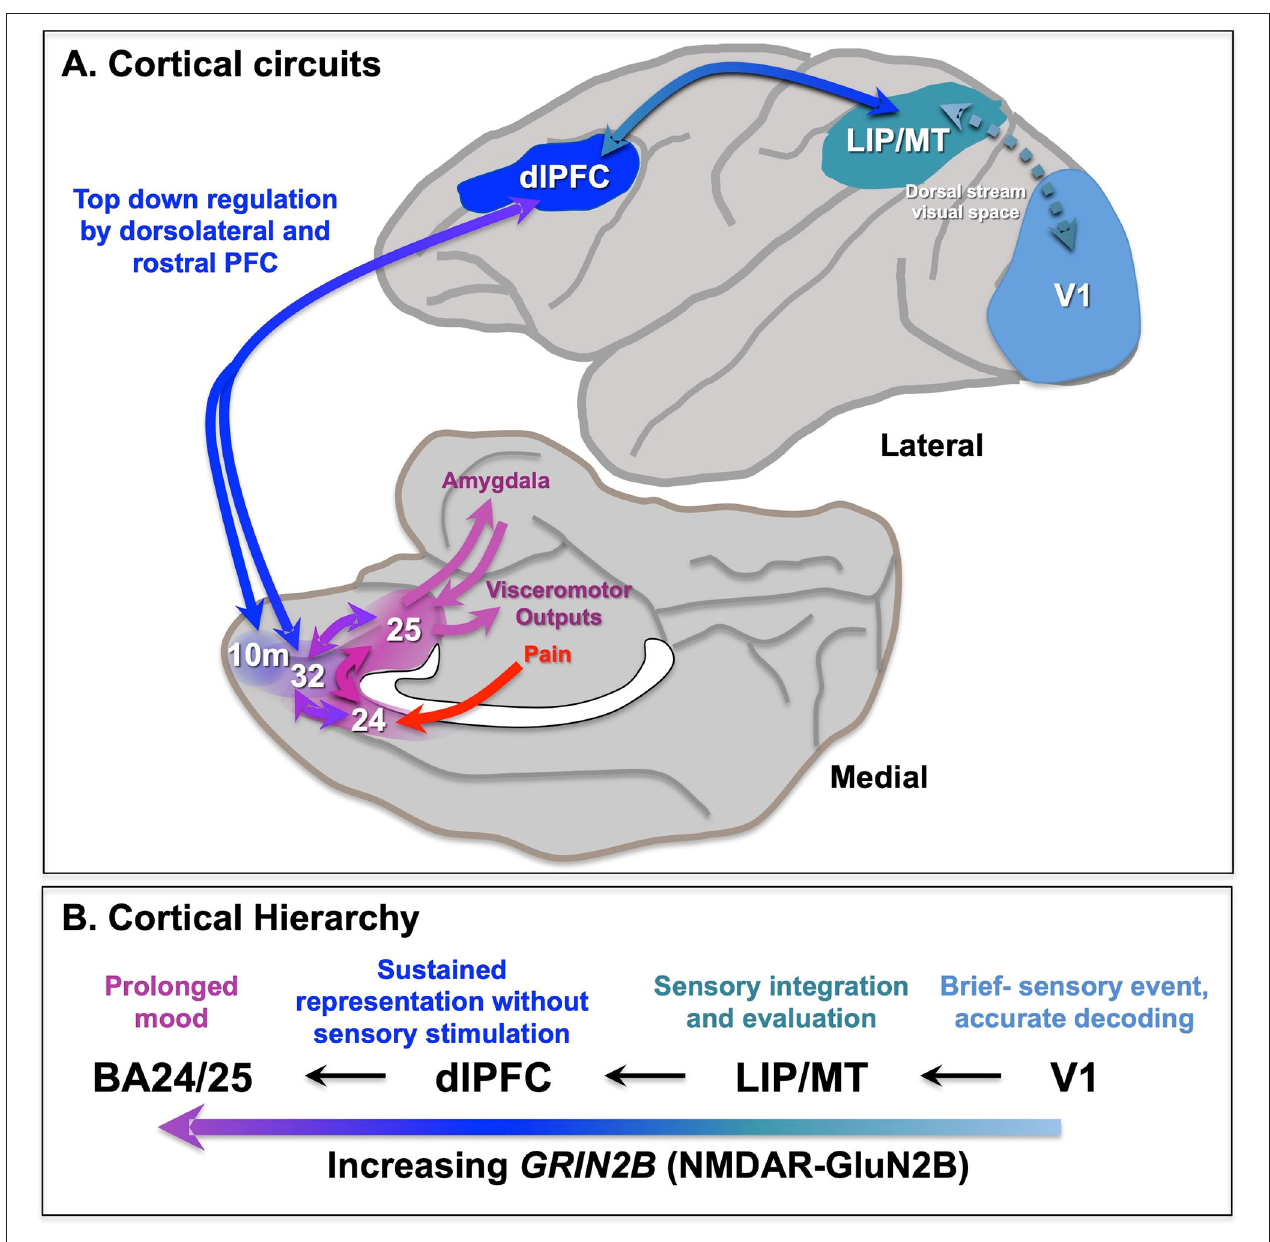
FIGURE 1 | Primate cortical circuits. (A) Schematic diagram of circuits in the rhesus monkey cortex, where the lateral surface represents the outer world, and the medial and orbital surface represents inner state. The dorsal stream is shown on the lateral surface, where dlPFC represents visual space in working memory, and generates the goals for top-down regulation of emotion. The medial surface shows the pathways mediating the emotional response to pain, arising from medial thalamic projections to the insular cortex (not shown) and the anterior cingulate cortex BA24, which both project to BA25 (subgenual cingulate). BA25 is a major center for visceromotor outputs, e.g., to the amygdala, brainstem, and hypothalamus to alter heart rate. These cingulate cortices are often overactive in depression, and a target of DBS treatments. The dlPFC provides top-down regulation of emotion through indirect projections to BA25 via areas BA10m and BA32, and direct projections to BA24 (not shown). (B) The increasing timescales across the primate cortical hierarchy, and their relationship to GRIN2B expression. Based on (11) and (9). LIP, lateral intraparietal cortex; MT, middle temporal visual cortex.